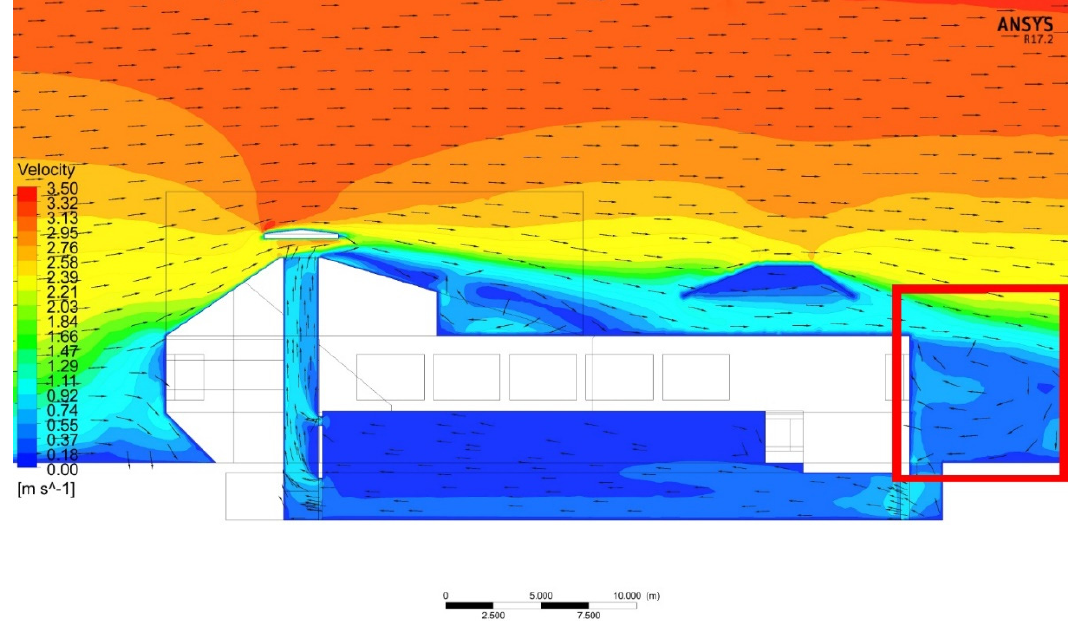
Figure 9. Backflow occurrence behind the building in case of approaching wind direction from SE in the UD PACS (colors and vectors by air velocity [m/s]).